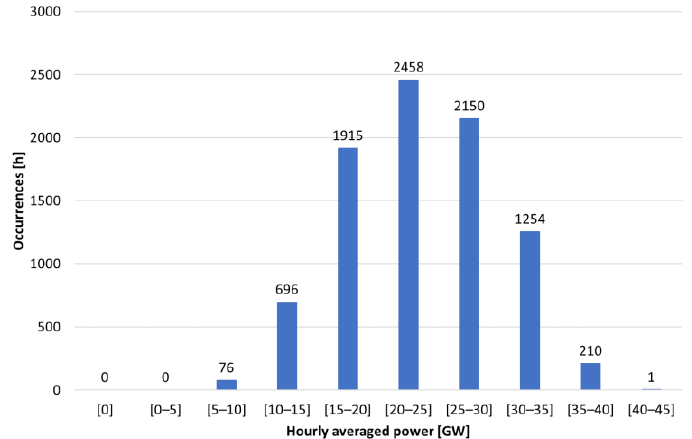
Figure 8. Distribution of hourly averaged power of non-renewable sources during the reference year (2019).